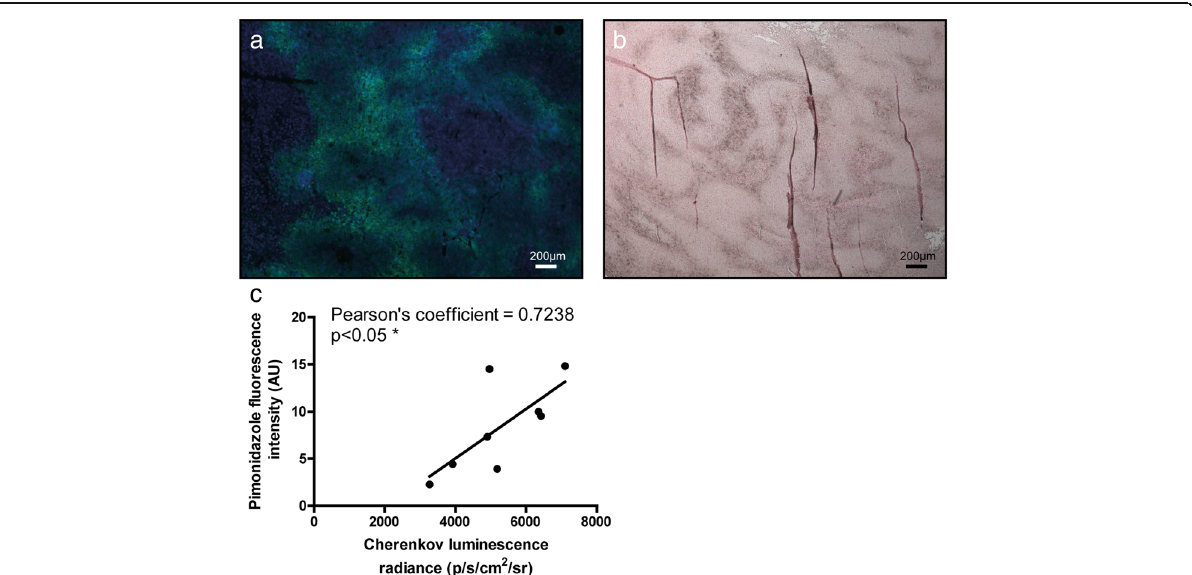
Fig. 3 Microscopic slides of tumours for the same mouse as for Fig. 2a, b with pimonidazole staining (× 50 magnification). Hypoxic regions are shown either in green ( a fluorescence microscopy) or in brown ( b transmitted light microscopy). c Correlation between Cherenkov luminescence imaging following the injection of FMISO and fluorescence pimonidazole staining ( n =9, Pearson ’ s coefficient=0.7238, p <0.05*). Results are presented as radiance (p/s/cm 2 /sr) for CLI and fluorescence intensity (arbitrary units, AU) of